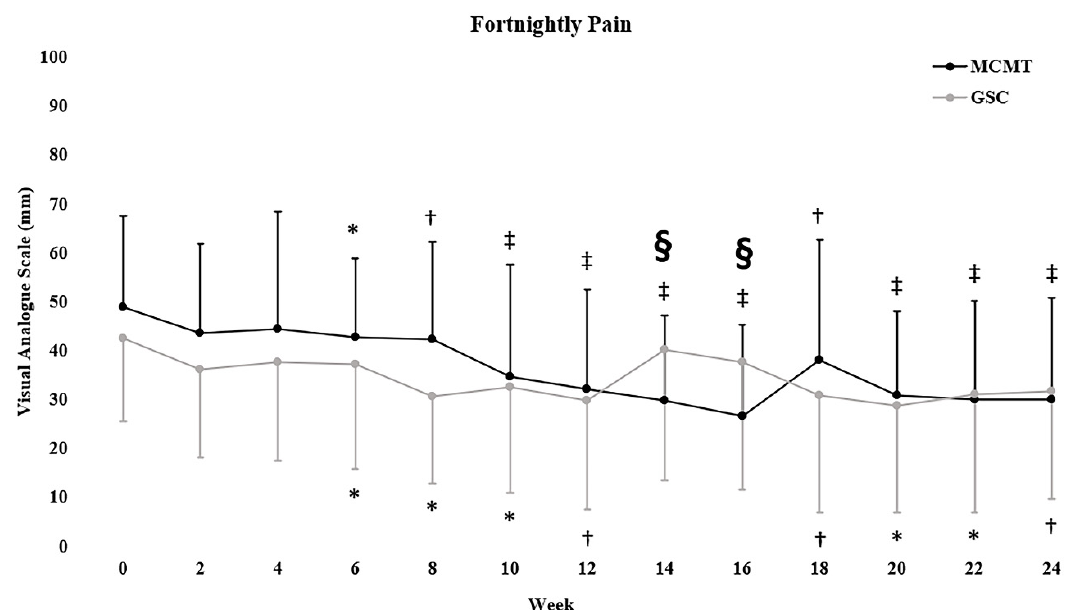
Figure 3. Mean ± standard deviation fortnightly pain (VAS) data. § p < 0.01 indicates significant between-group effect at that week. * p < 0.05, † p < 0.01, ‡ p < 0.001 indicate within-group change. Symbols above error bars refer to significant changes within the MCMT group, symbols below the error bars to the GSC group.